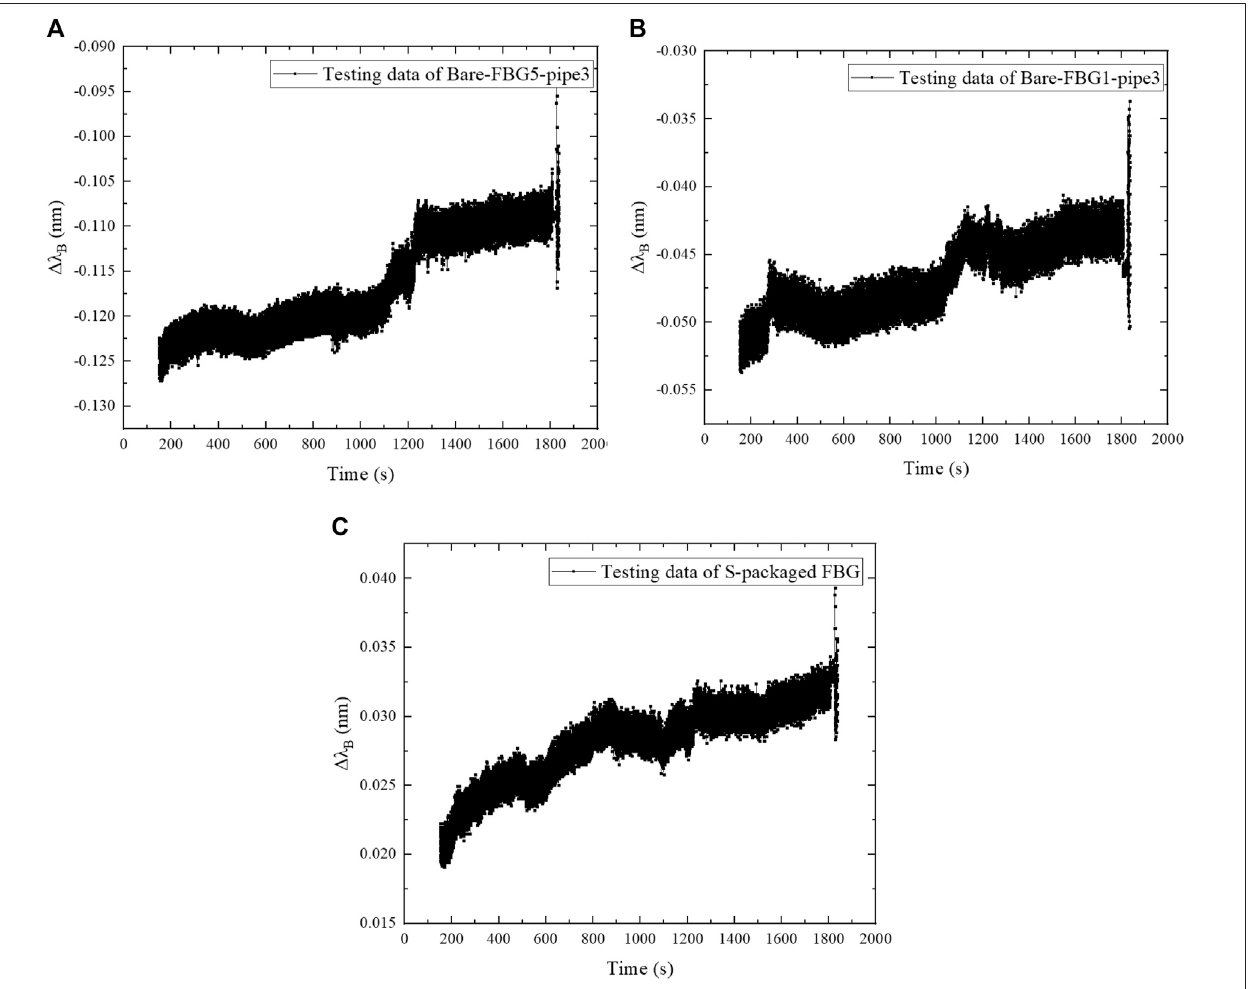
FIGURE 11 | Relationship of central wavelength increment with loading time at 30 Hz: (A) Bare-FBG5-pipe3; (B) Bare-FBG1-pipe3; (C) S-packaged FBG.